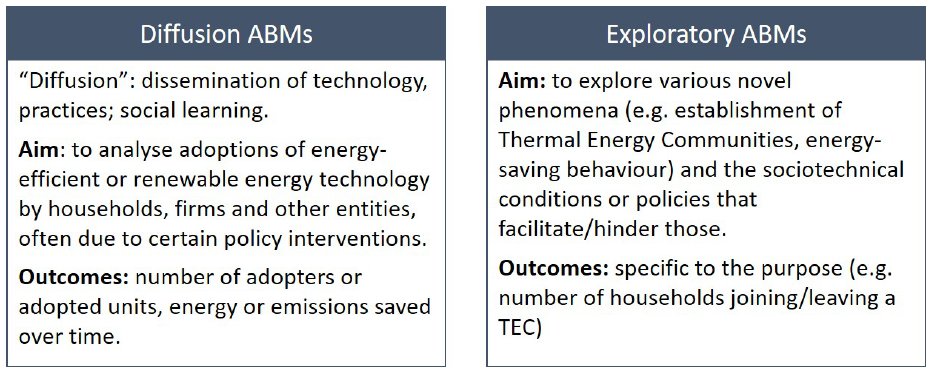
Figure 3. Two major thematic clusters based on model purposes within the ABM of urban district energy